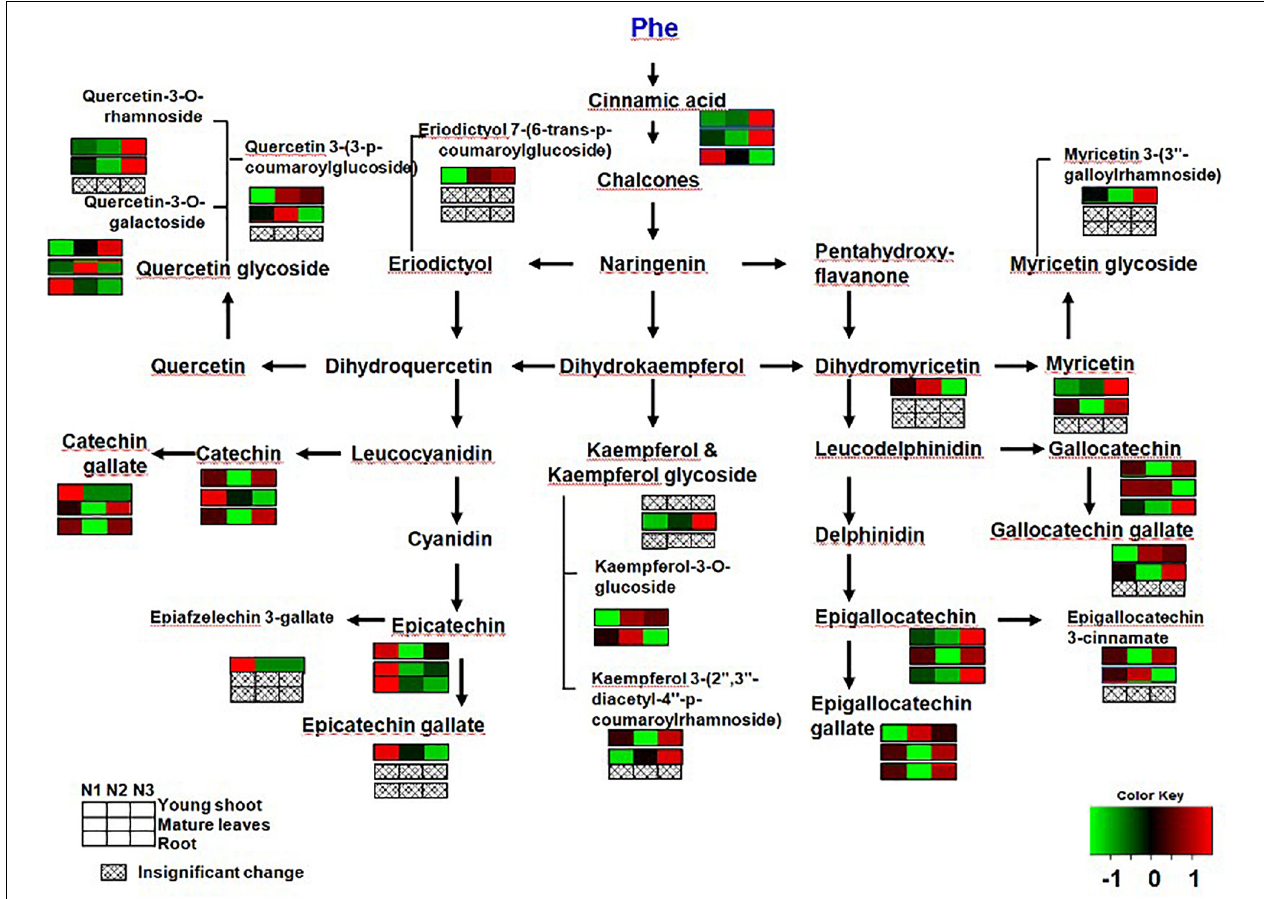
FIGURE 4 | Changes in secondary metabolites of young shoots, mature leaves, and roots under low (0.3 mmol/L, N1), intermediate (1.5 mmol/L, N2), and high levels of nitrogen (4.5 mmol/L, N3). The relative abundance of metabolites is illustrated on a red (high) to green (low) scale. The differences were considered to be significant when p <